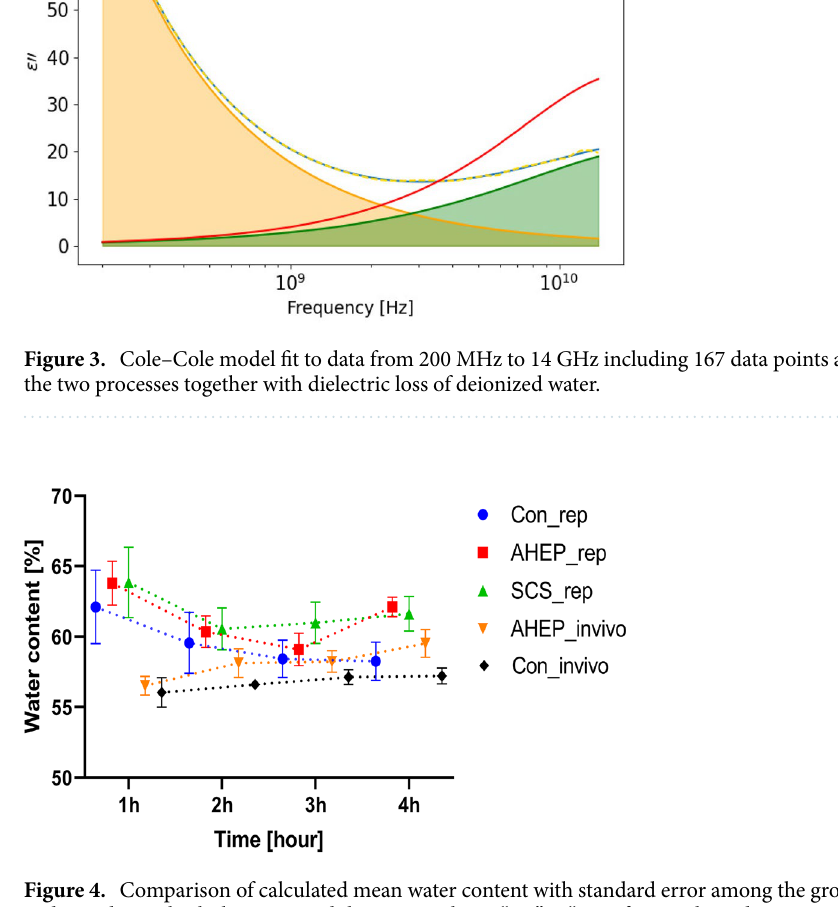
Figure 4. Comparison of calculated mean water content with standard error among the groups: Control, AHEP and SCS during both the NMP and the in vivo phase. “rep” = “reperfusion phase during NMP”, “invivo” =“in vivo